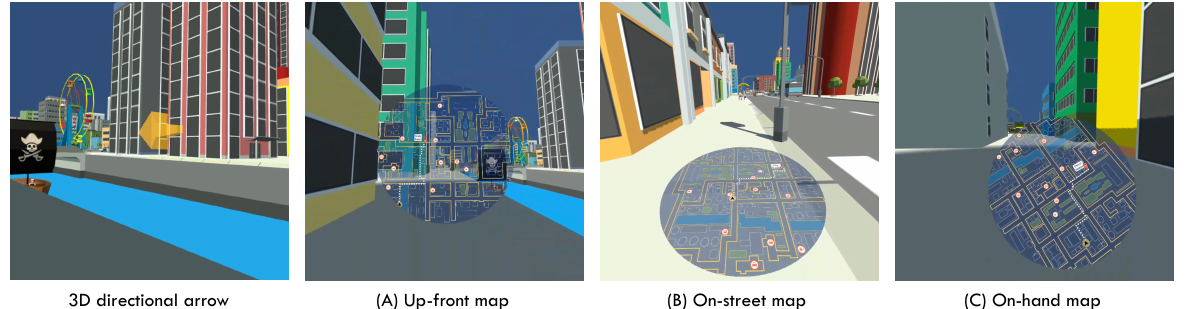
Figure 1. The AR application to support pedestrian navigation featured a directional arrow to display turn directions when the map was not in use (as shown in the far left image). For the AR map view, we investigated three different map positions: up-front map ( A ), on-street map ( B ) and on-hand map ( C